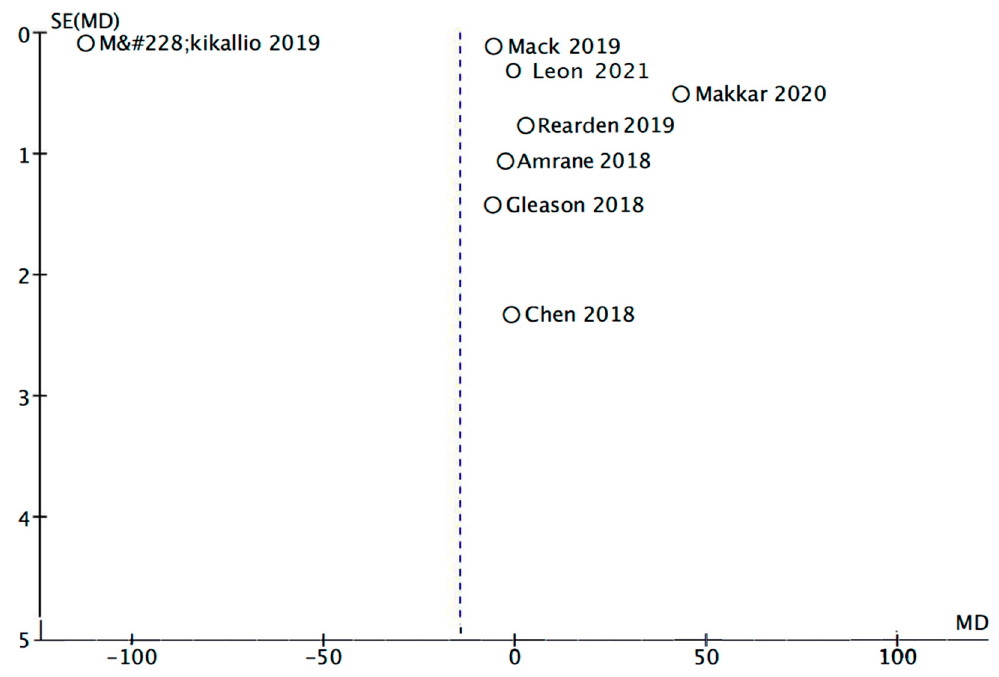
Figure 5. Funnel plot for publication bias (stroke).